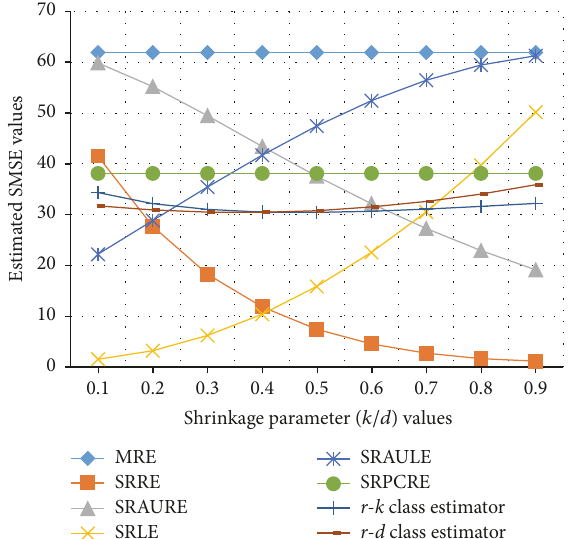
Figure 1: SMSE values of the estimators in the misspecified regression model ((𝑙,𝑝) = ( 3, 2 )) when 𝑛 = 50 and 𝜌 = 0.9 .